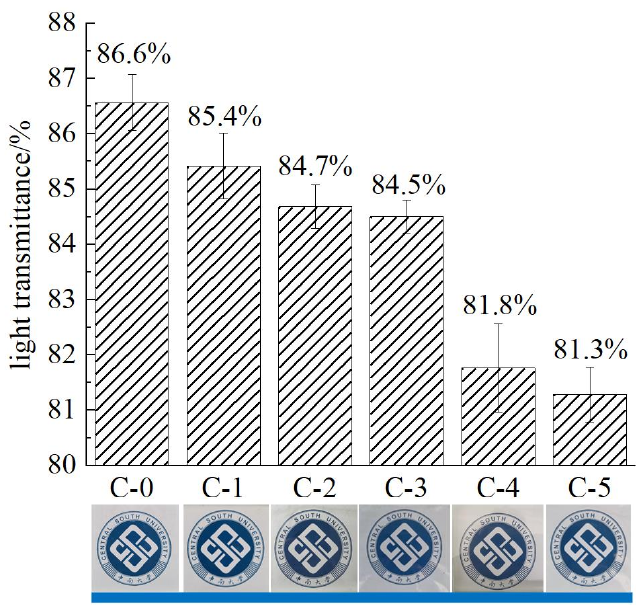
Figure 4. Light transmittance of fireproof glass samples.